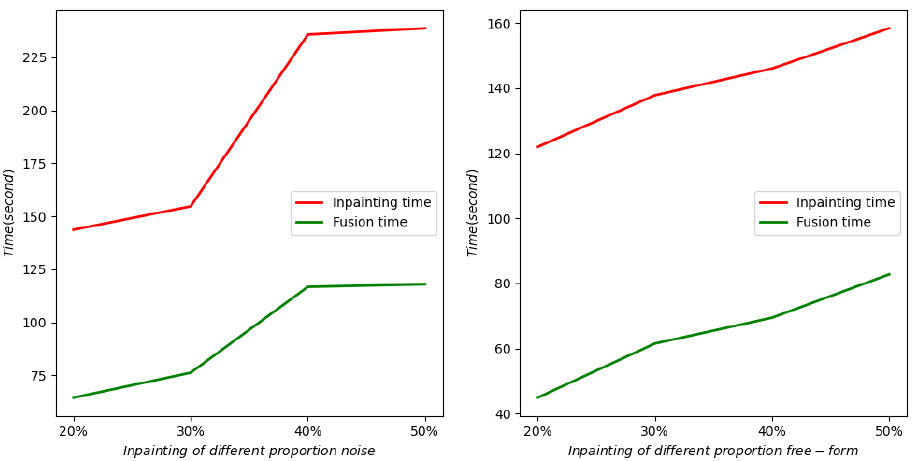
Figure 14. The graph of the average completion time of 1000 face images with random noise masks and random free-form brush